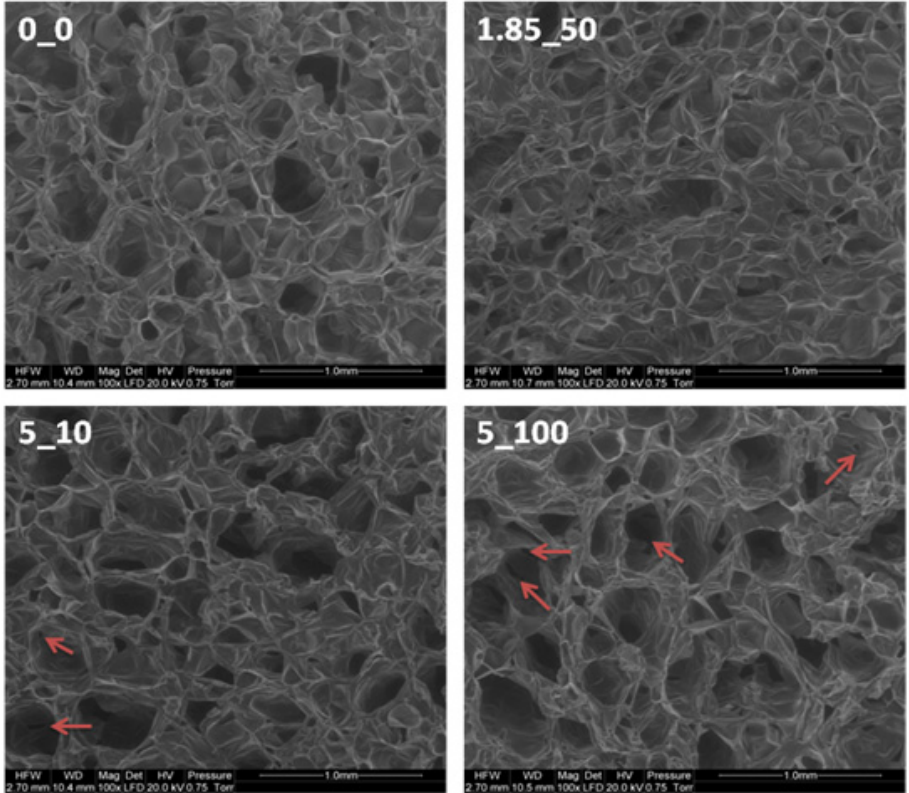
Figure 4. SEM images of untreated (0_0) and PEF treated (1.85_50—E = 1.85 kV cm − 1 , n = 50 pulses; 5_10—E = 5 kV cm − 1 , n = 10 pulses; 5_100—E = 5 kV cm − 1 , n = 100 pulses) fresh apple tissue. Red arrows indicate the damages and ruptures in cell structure. Magnification of × 100. E—electric field intensity of applied PEF [kV cm − 1 ]; n—number of pulses. Source: own elaboration, unpublished data.